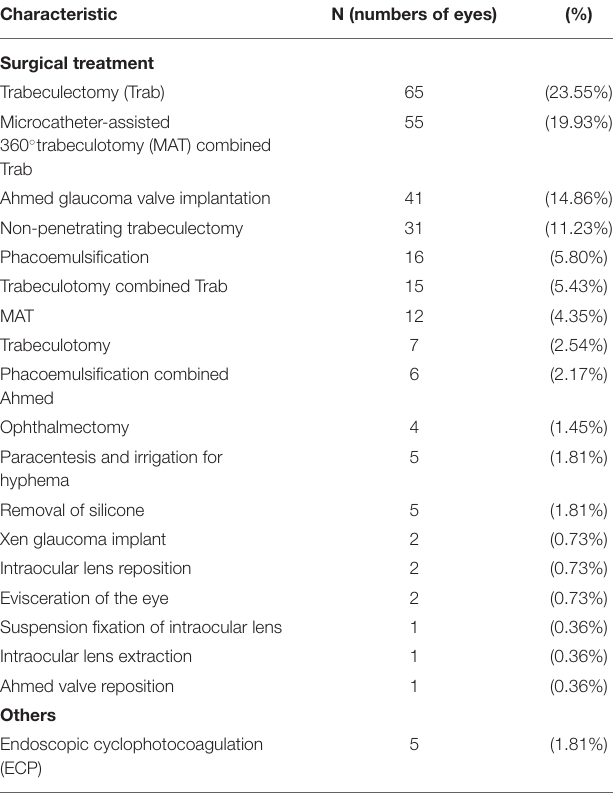
TABLE 4 | Management of pediatric glaucoma patients *